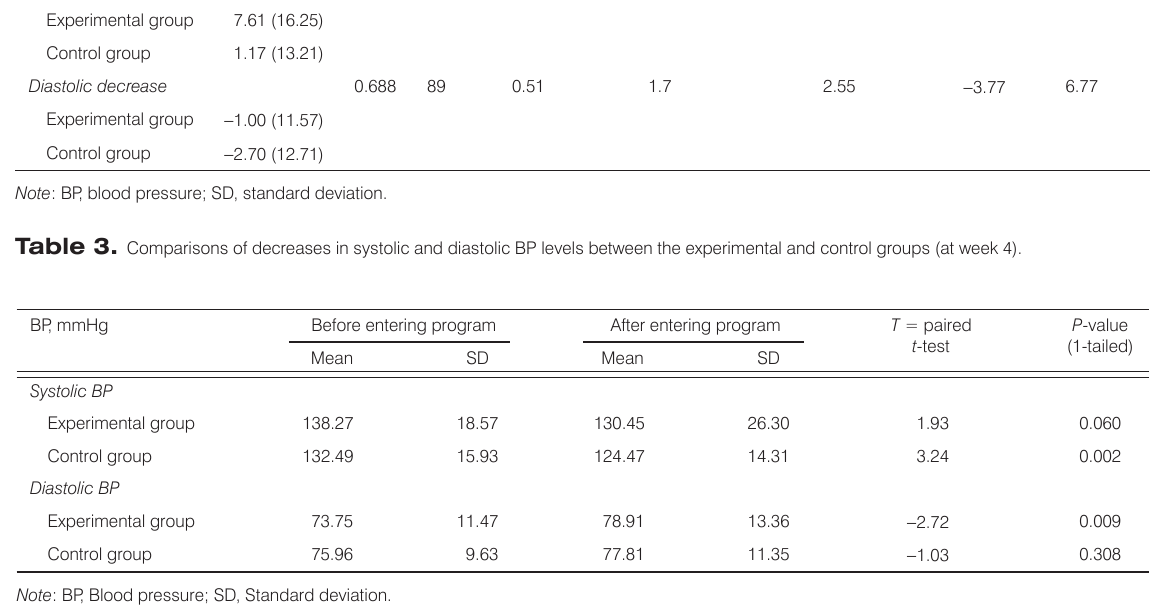
Table 4. Comparison of BP levels within experimental group and control group before – after entering the Program (at the 13th